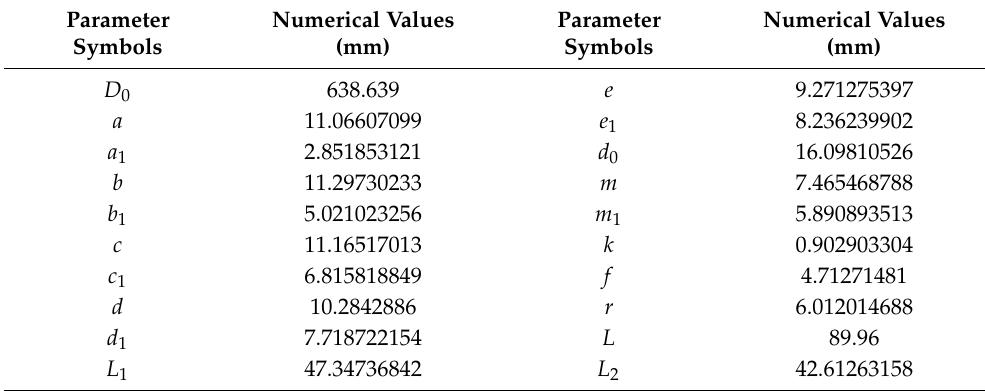
Table 1. Airfoil design